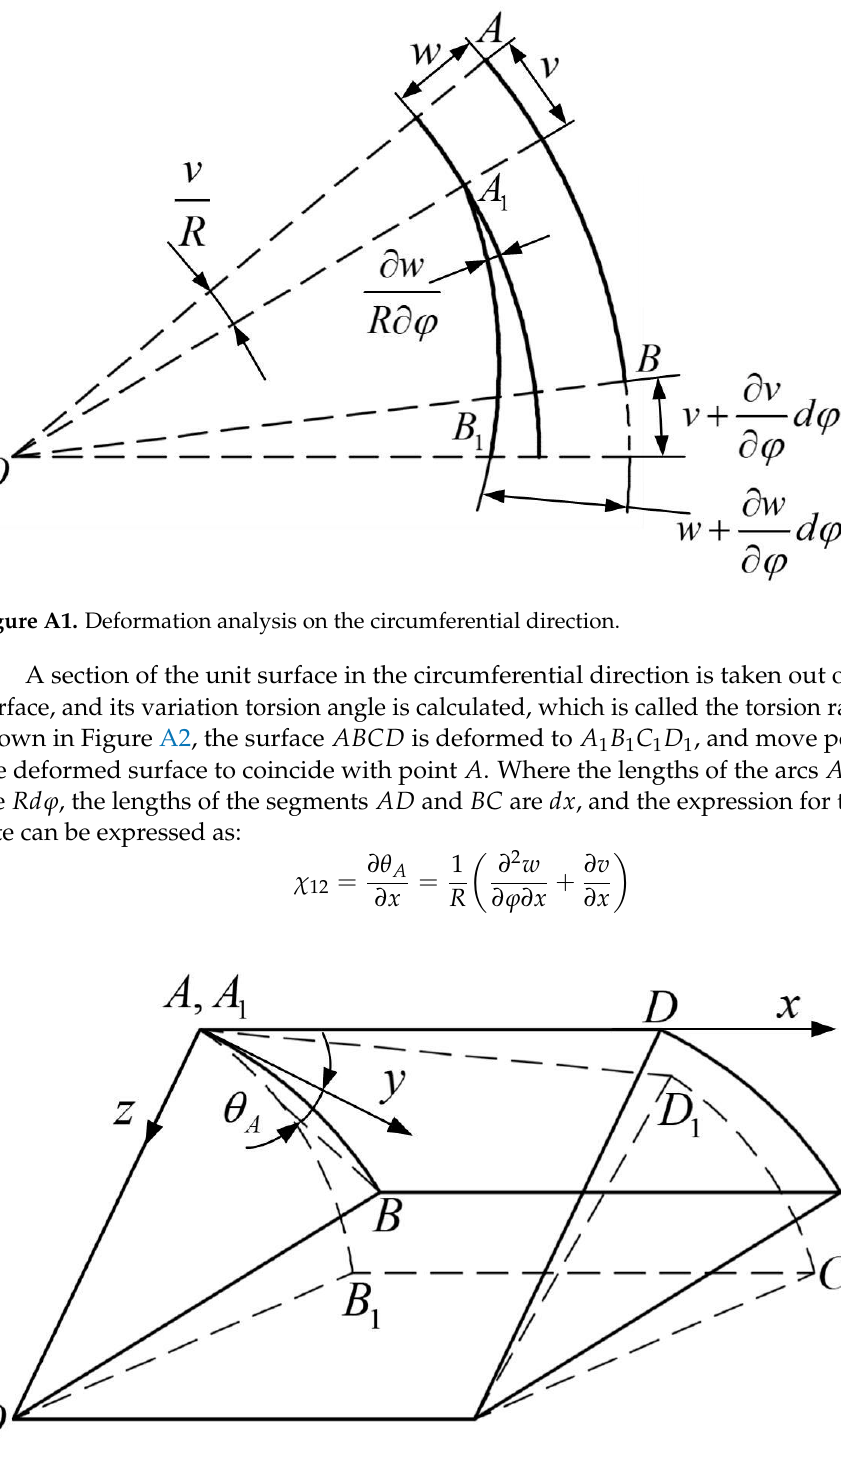
Figure A2. Torsional deformation of the unit body in the shell.